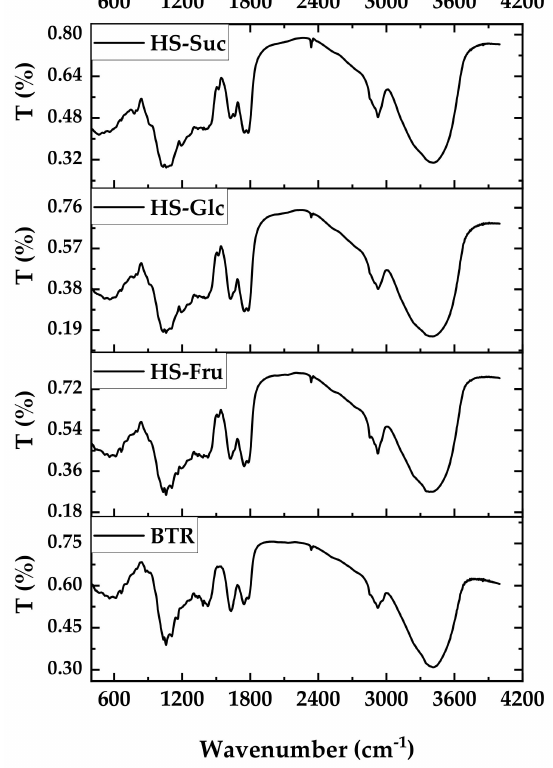
Figure 7. FT-IR spectra of BNC produced in BTR and HS